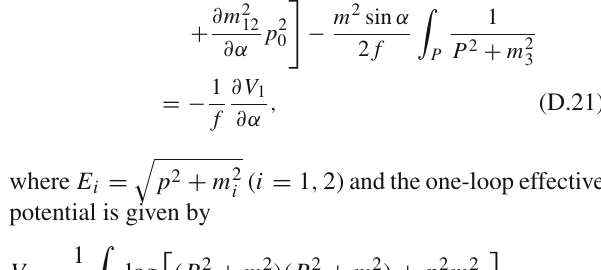
Fig. 6 One-loop tadpole diagram contributing to the one-point